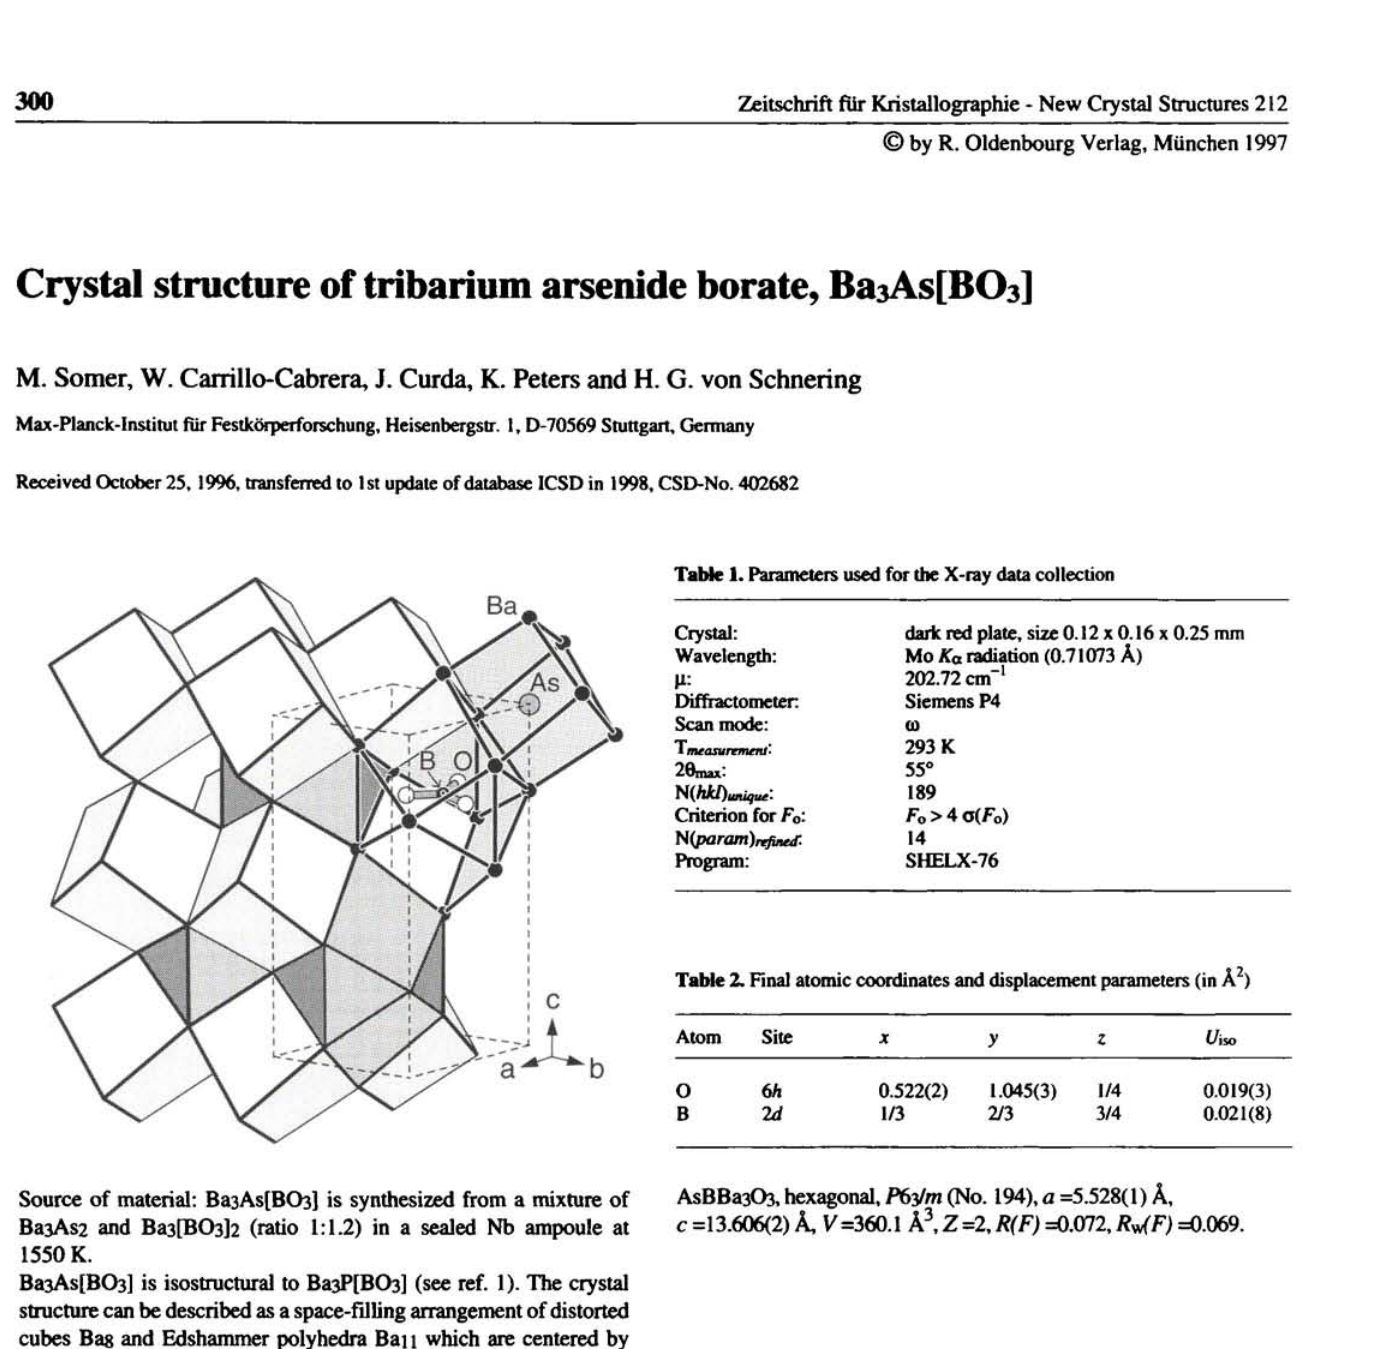
AsBBa303, hexagonal, Ρ63 //Π (No. 194), a =5.528(1)